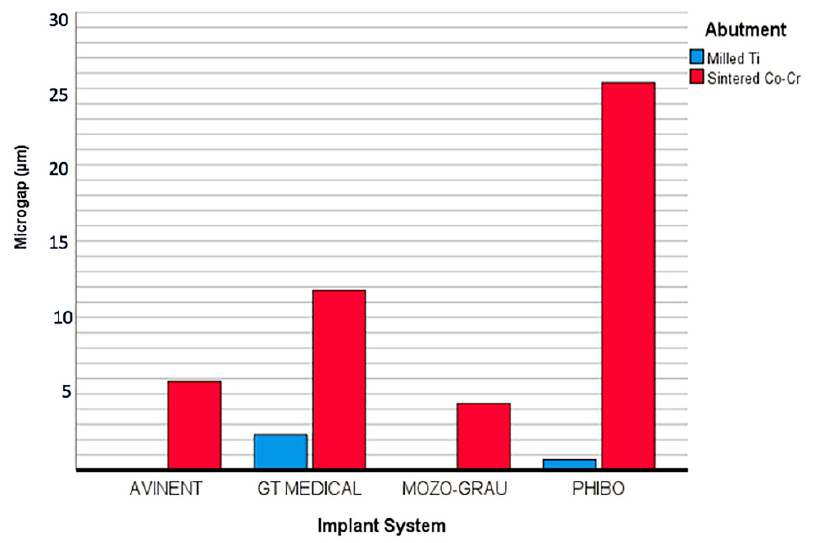
Figure 3. Graph of misfit values between the implant systems.